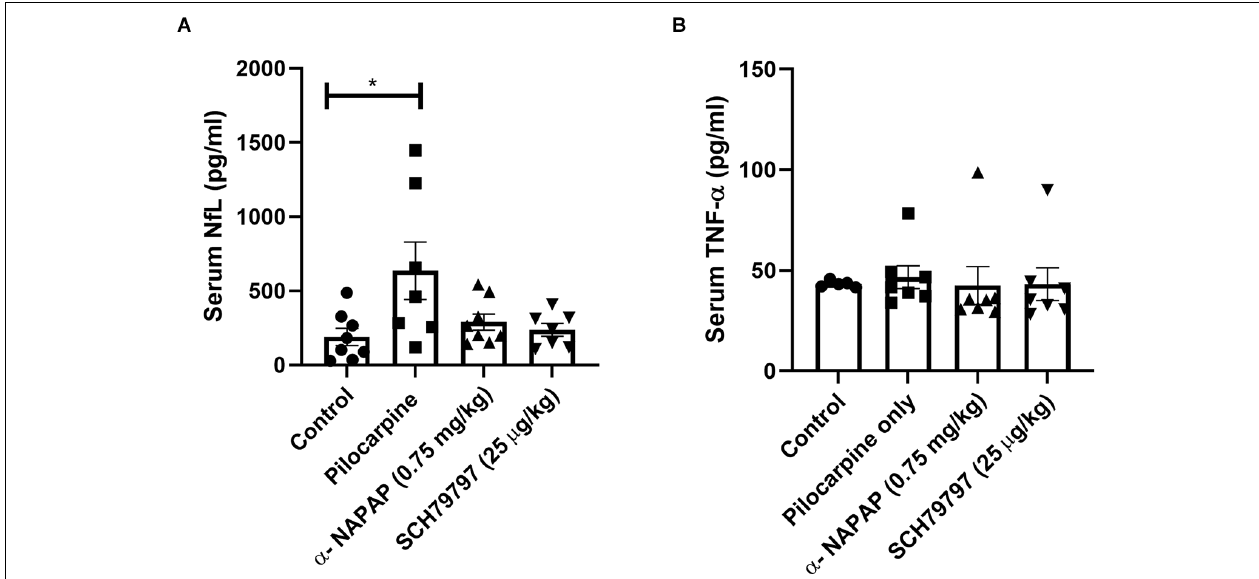
FIGURE 3 | Elevation in serum marker for neuronal damage, prevented by thrombin PAR1 pathway inhibition. (A) Serum levels of NfL, a marker for neuronal damage, were elevated in pilocarpine only animals. Thrombin PAR1 pathway inhibitors prevented the increased NfL levels. (B) Systemic inflammation as evaluated by TNF- α levels was similar in all four groups. * p <